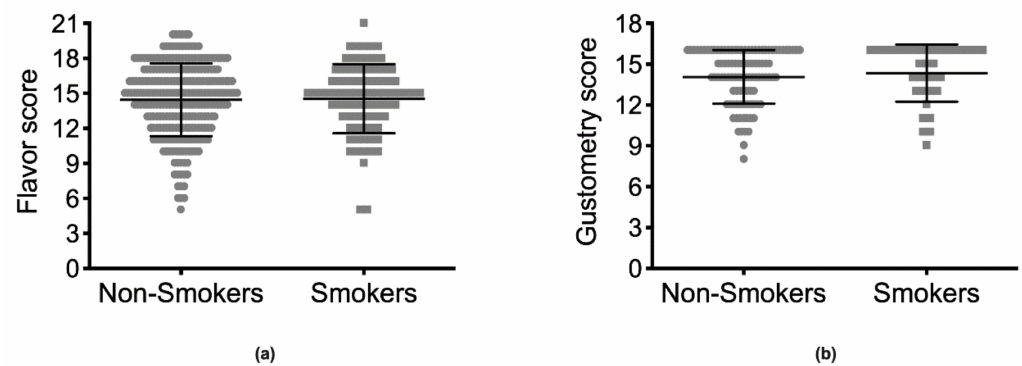
Figure 3. Flavor and gustometry scores according to smoking habit. Mean ± SD of the flavor score ( a ) and gustometry score ( b ) for non-smokers and smokers. No significant di ff erences can be determined between the two groups for either flavor or gustometry